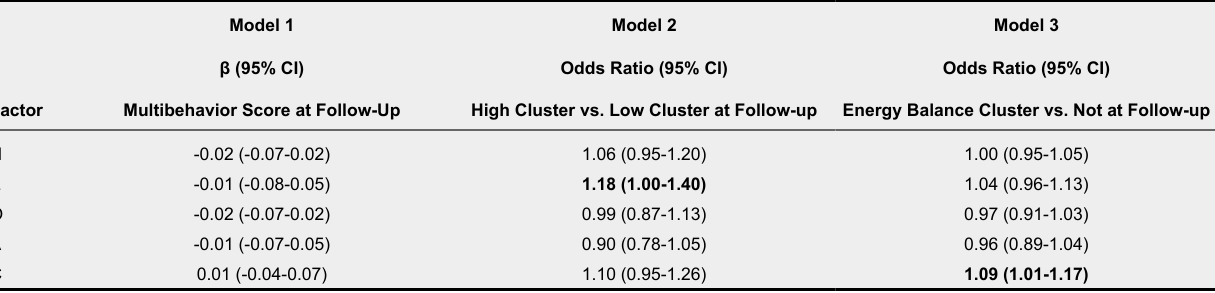
Multivariable Regression Models Evaluating the Association Between Personality Types and Multibehavior and Behavioral Clustering at the 5-Month